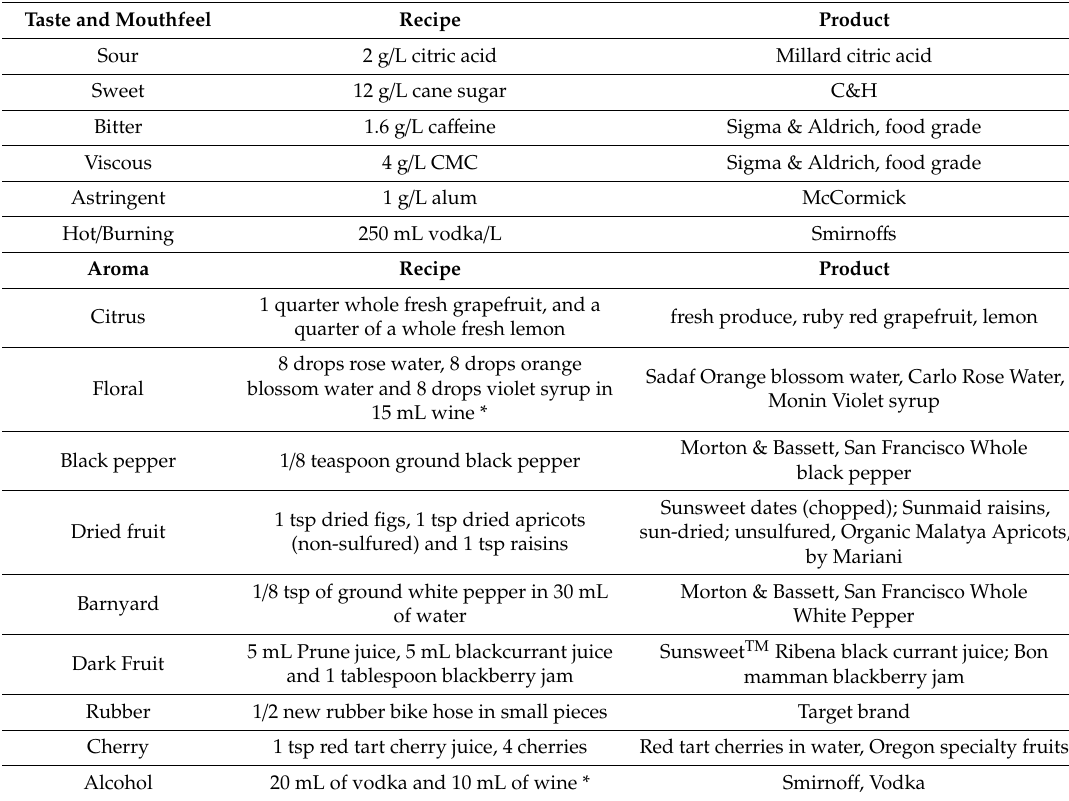
Table 2. Complete list of descriptors and